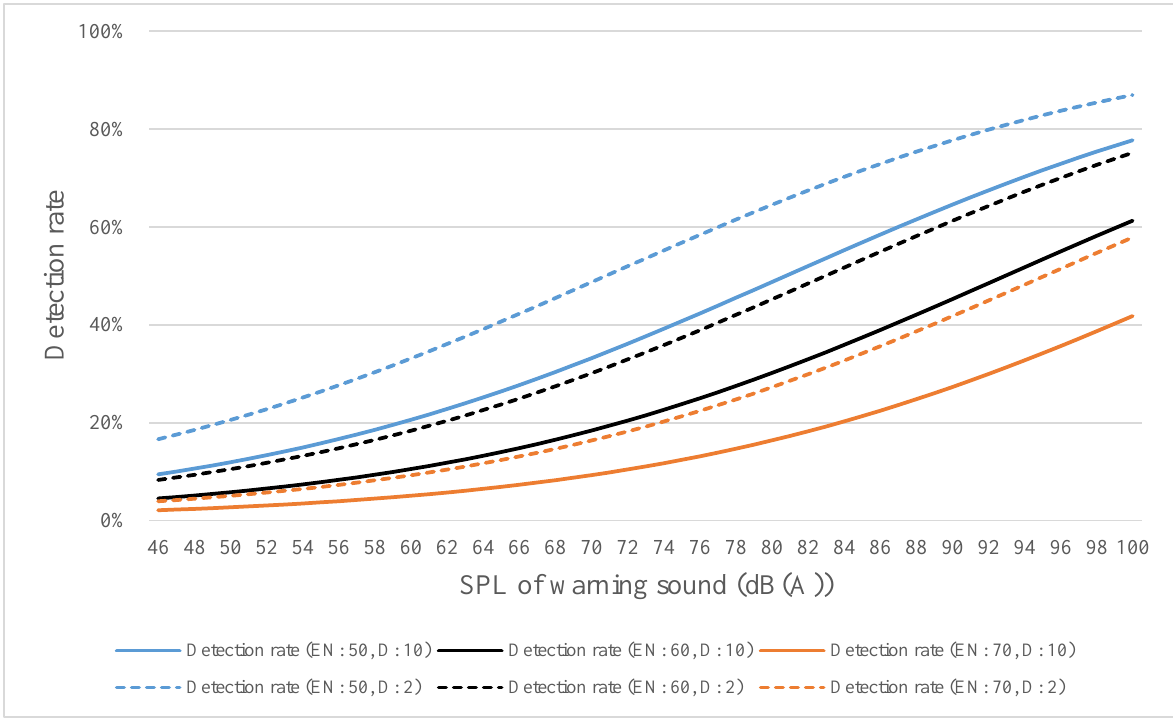
Figure 11. Estimated detection rate for medium-frequency warning sound as calculated using Equation (5) (EN denotes environmental noise; D denotes distance).